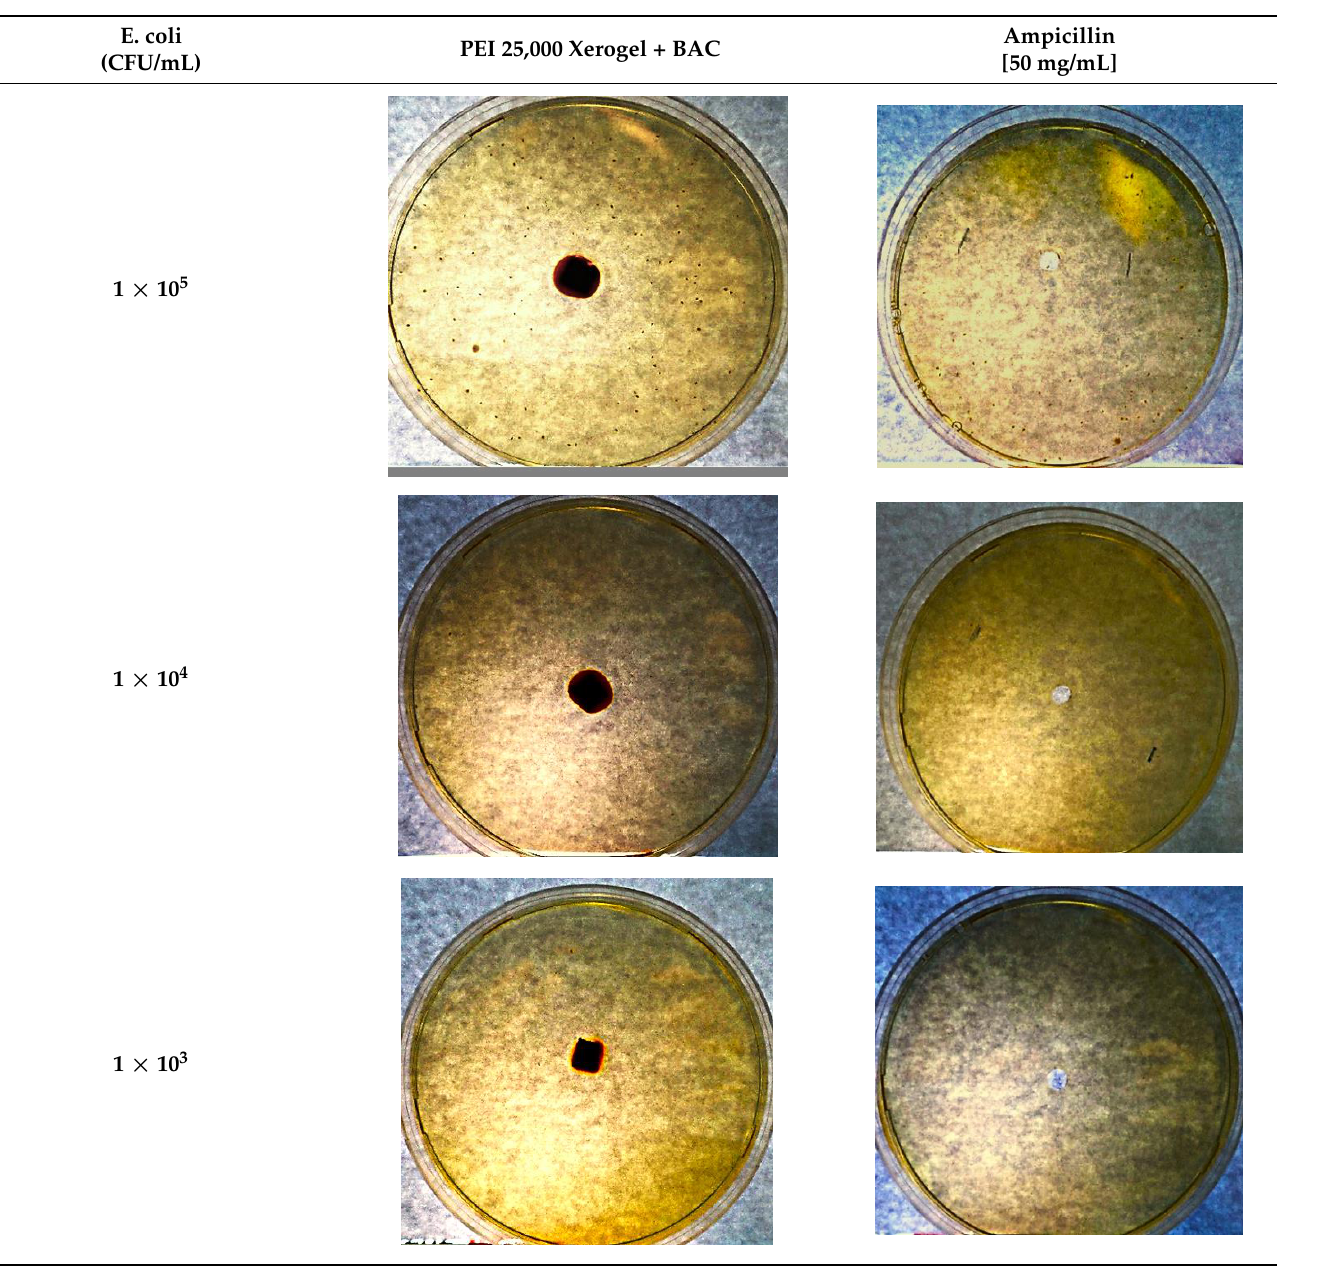
18 Table 7. Luria – Bertani (LB)-medium agar plates, bearing at the center either leather samples (left) or 20 μ L ampicillin (50 μ g/mL) (right), incubated with different densities of Escherichia coli ATCC 25922 E cultures. E. coli